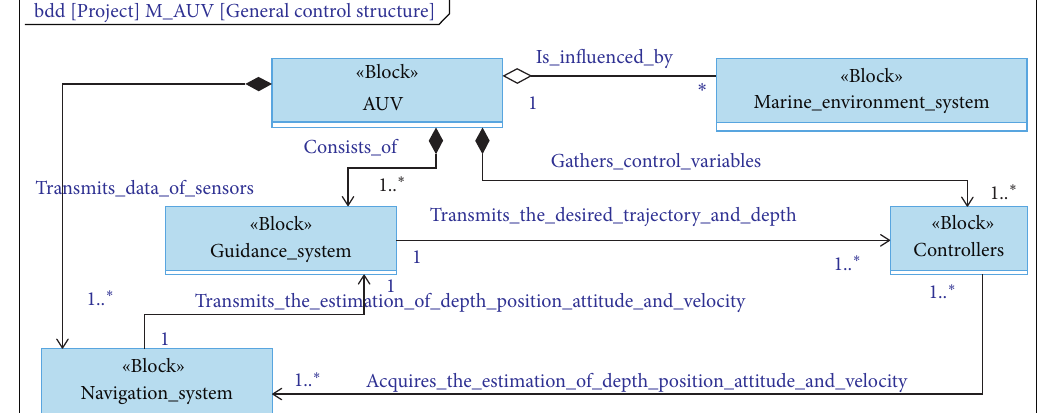
Figure 1: Block definition diagram of autonomy architecture for an AUV.